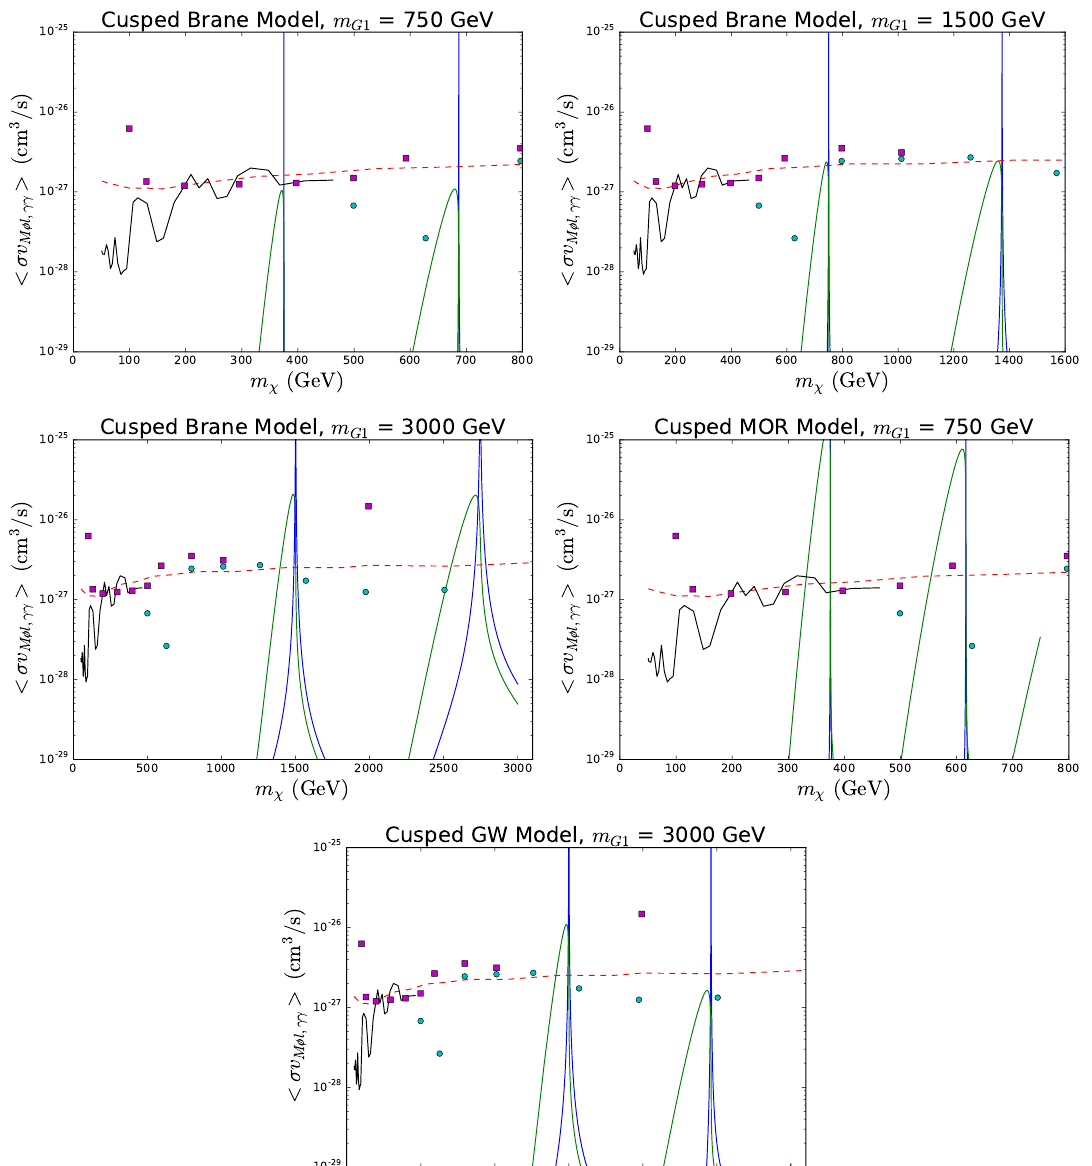
Figure 6 . Assuming a cusped pro(cid:12)le, the thermally averaged dark matter annihilation cross section into two photons at z = 0 (at thermal freeze-out) for spin-1 dark matter as a function of the DM mass is given by the blue (green) curve for the 5 benchmark models as labeled. The photon line search limits from FERMI (solid black), HESS I (cyan circles), and HESS II (magenta squares) are also shown, as well as the projected sensitivity of the Cerenkov Telescope Array (red-dashed line).